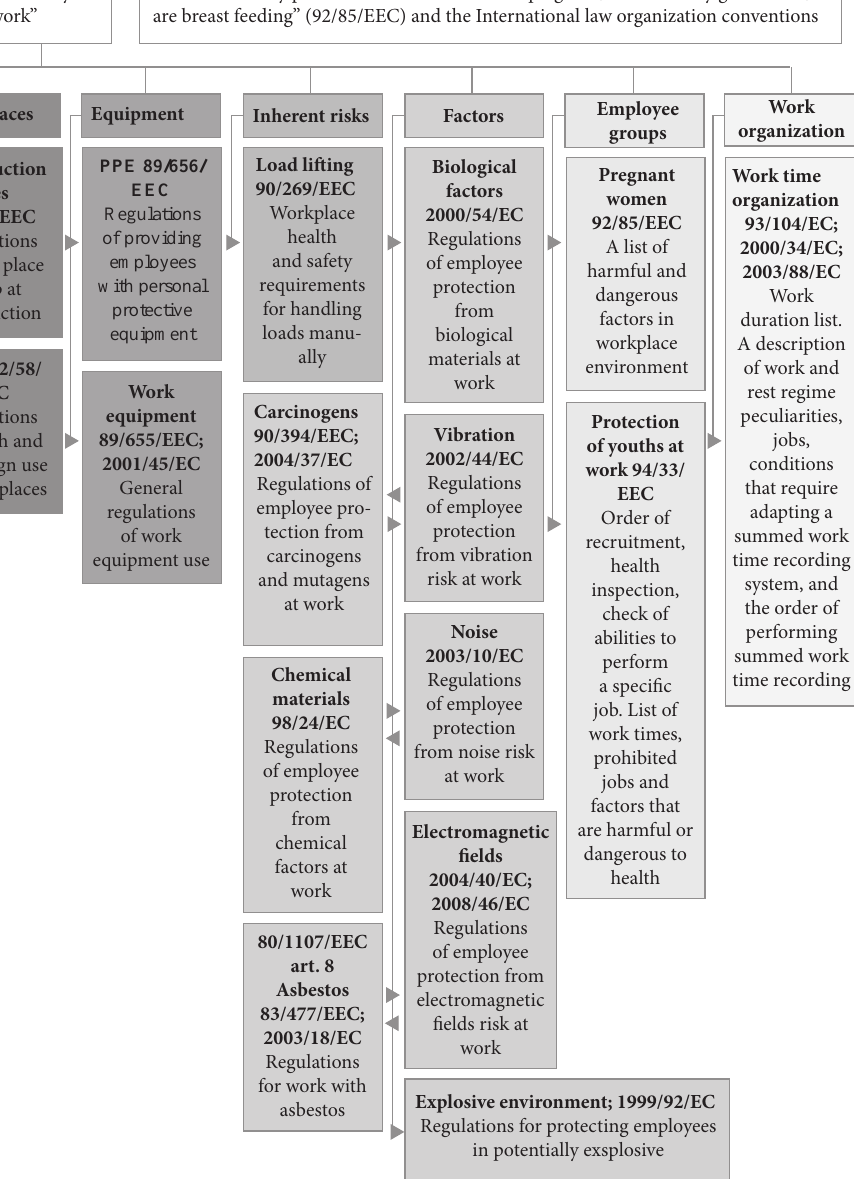
Fig. 6. The EU directives that ensure workplace health and safety in Lithuanian construction